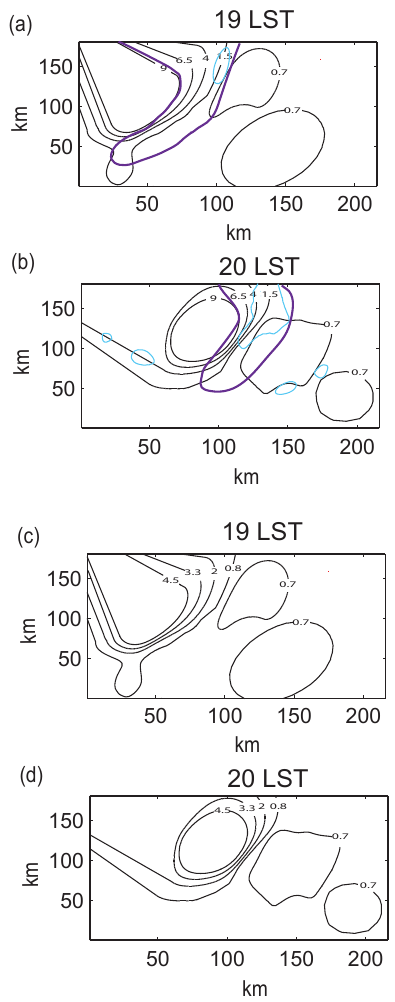
Figure 4. Spatial distributions of background aerosol number con- centrations at the surface (black contours; in × 10 3 cm − 3 ) and the boundary of each area that has a precipitation rate of 60mmh − 1 or above (blue contours) in Domain 3 at (a) 19:00 and (b) 20:00LST. Purple lines in panels (a) and (b) mark a part of the domain in which there is a substantial reduction in aerosol number concentrations (see text for the details of purple lines). Panels (c) and (d) are the same as panels (a) and (b) , respectively, but with reduced contrast in aerosol number concentrations for the low-aerosol run (see text for the details of reduced